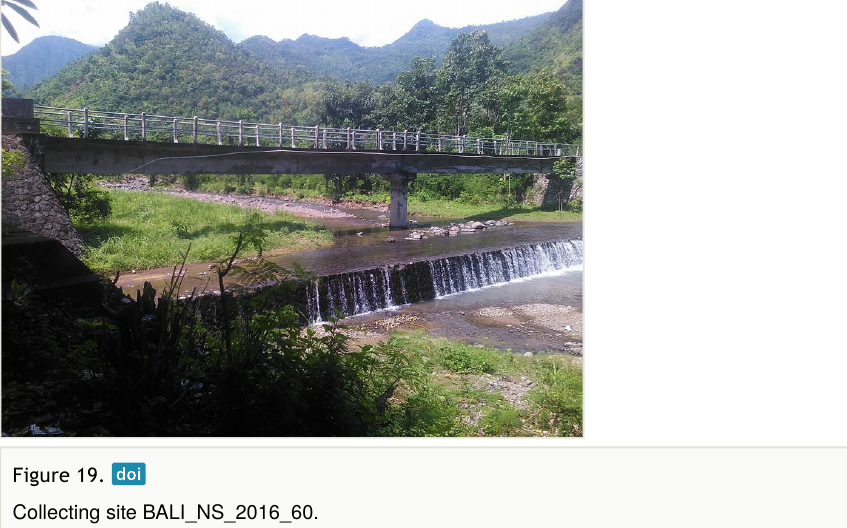
Collecting site